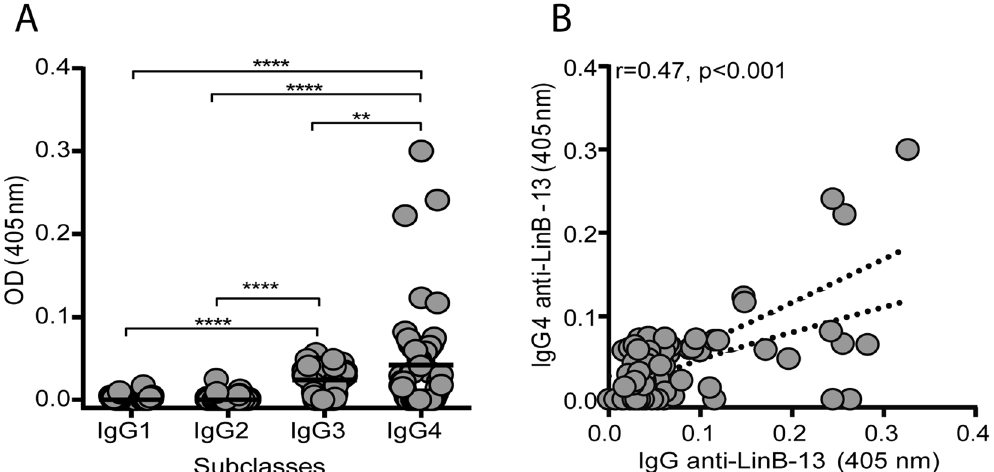
Figure 4. Anti-LinB-13 IgG subclasses detected in Lu. intermedia -exposed individuals. ( A ) IgG subclasses against LinB-13 were measured by ELISA using sera from residents of a CL-endemic area (n = 89). Black lines represent the median OD value for each antigen. ( B ) Spearman correlation between anti-LinB-13 IgG and IgG4 in the same individuals represented in ( A ). Data are shown individually ** P < 0.01; **** P <